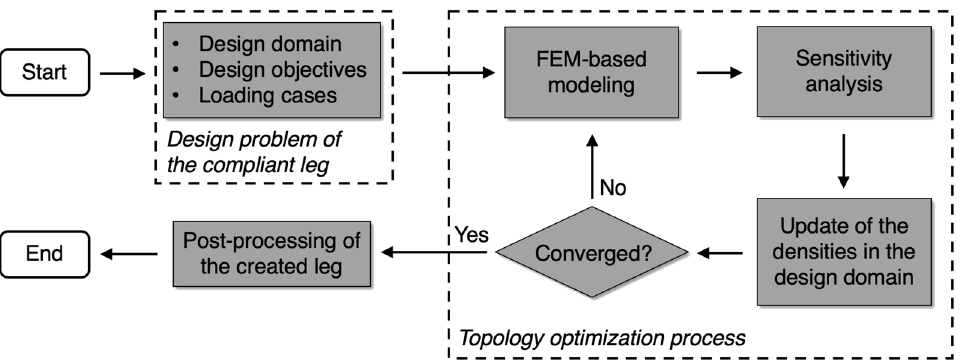
Figure 1. Workflow of the proposed topology-optimization-based design